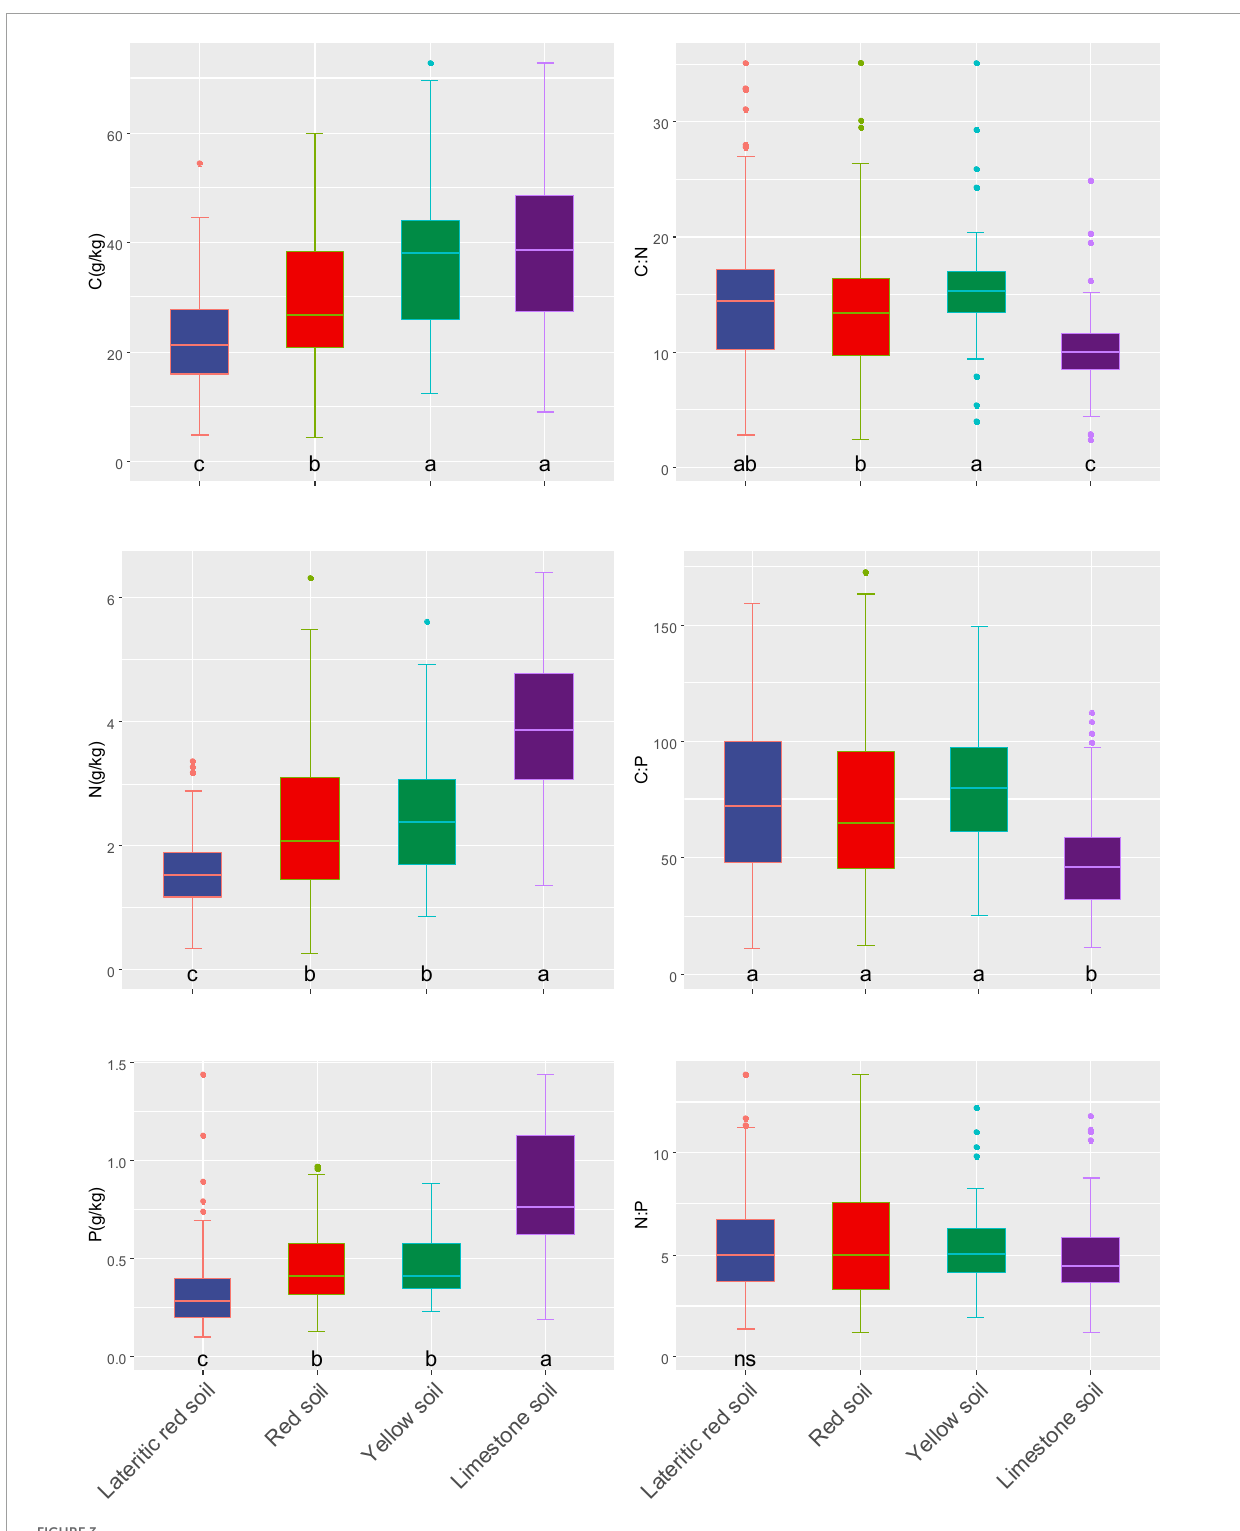
FIGURE3 The soil C, N, and P stoichiometric properties respectively under different soil types of the main forests in Guangxi.